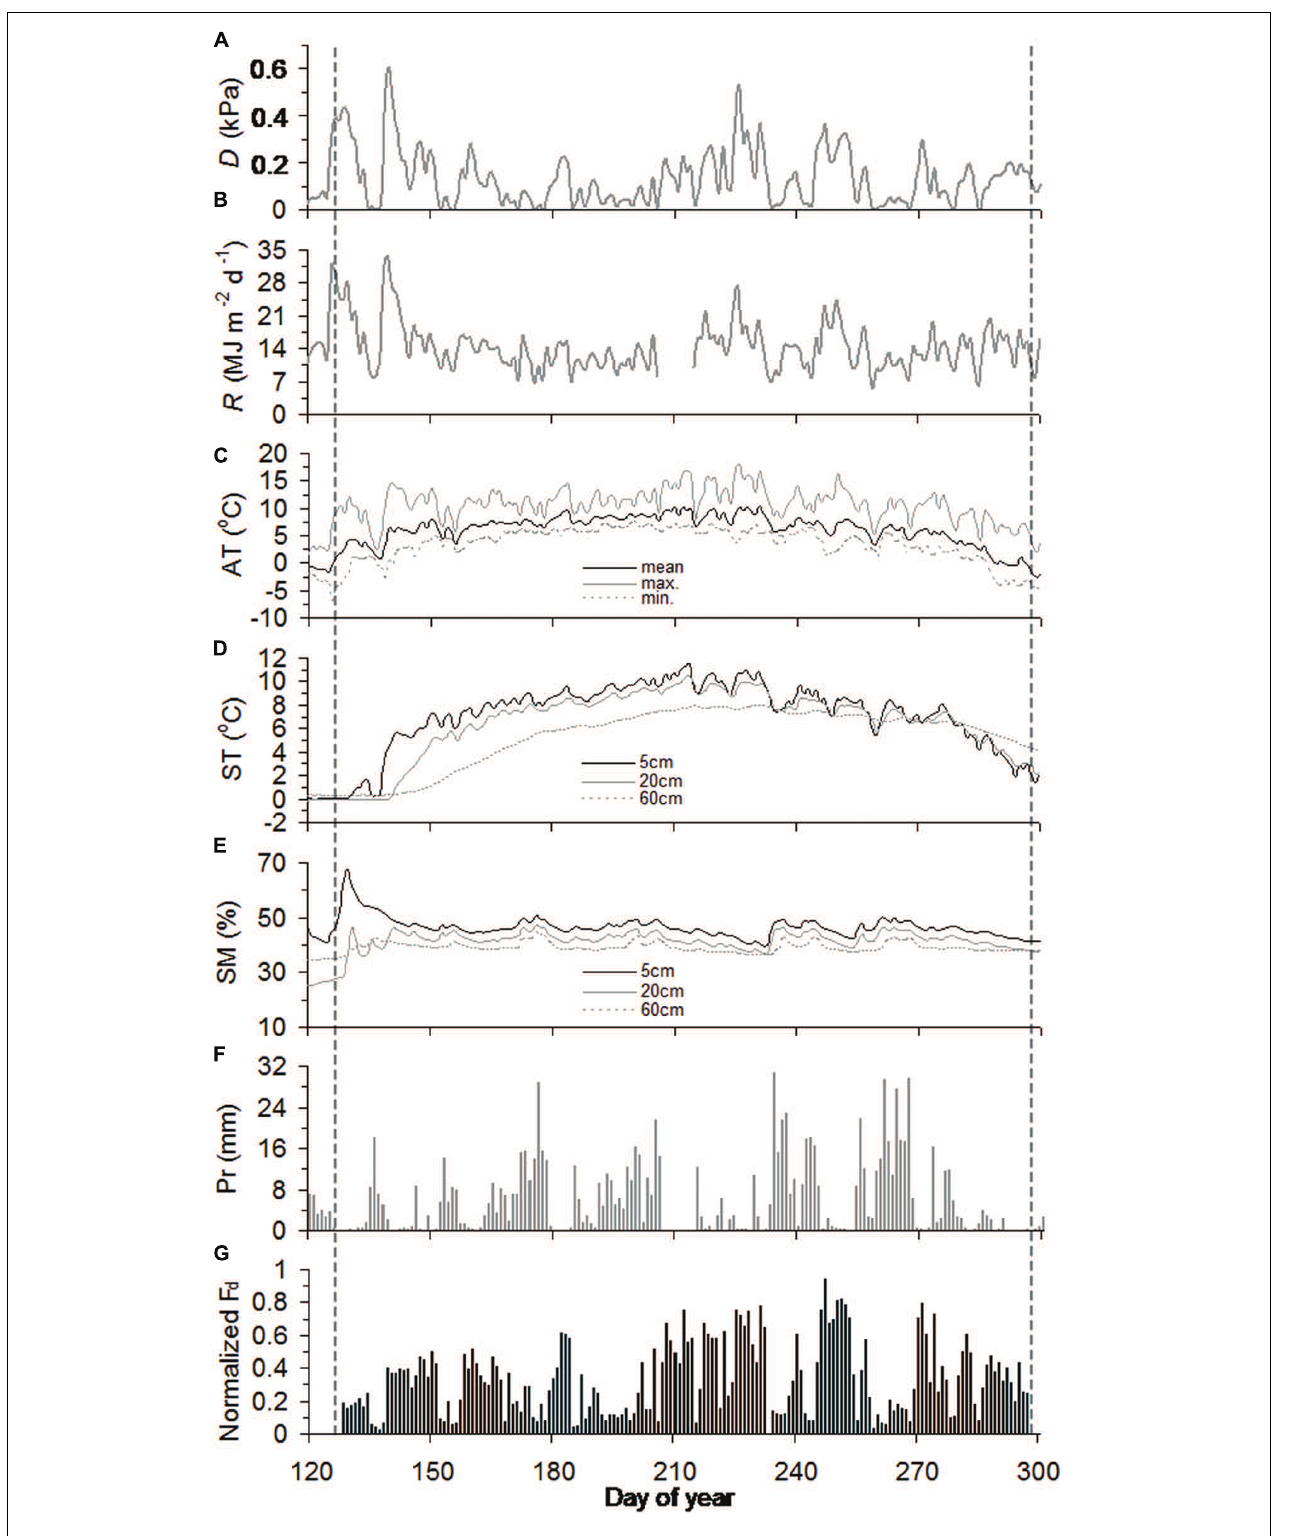
FIGURE 2 | Seasonal course of vapor pressure deficit ( D ) (A), solar radiation ( R ) (B), air temperature (AT) (C), soil temperature (ST) (D), soil moisture (SM) (E), precipitation (Pr) (F), and normalized daily sum sap flow density (normalized F d ) (G) for juniper trees during the growing season of 2012. The vertical black dashed lines highlight the timings of onset and ending of sap flow.